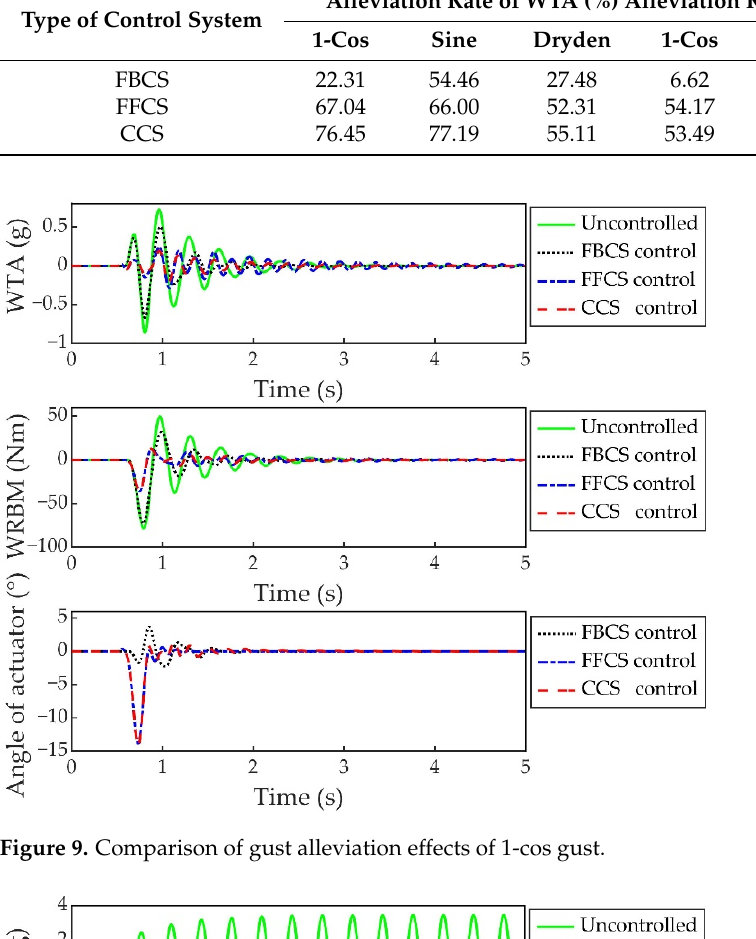
Figure 11. Comparison of gust alleviation effects of Dryden turbulence. 5. Wind Tunnel Test Design 5.1. Test Model and Gust Generator As shown in Figure 12 . , in the wind tunnel test, the wing model was fixed in the middle of the wind tunnel sidewall. A fairing fuselage is installed at the root of the wing, which is independent of the wing and has no effect on the stiffness of the wing. The de- tailed wing parameters are described in Section 4.1. The gust generator designed in the experiment is a two-stage, four-blade segmented device. The airfoil of the gust generator